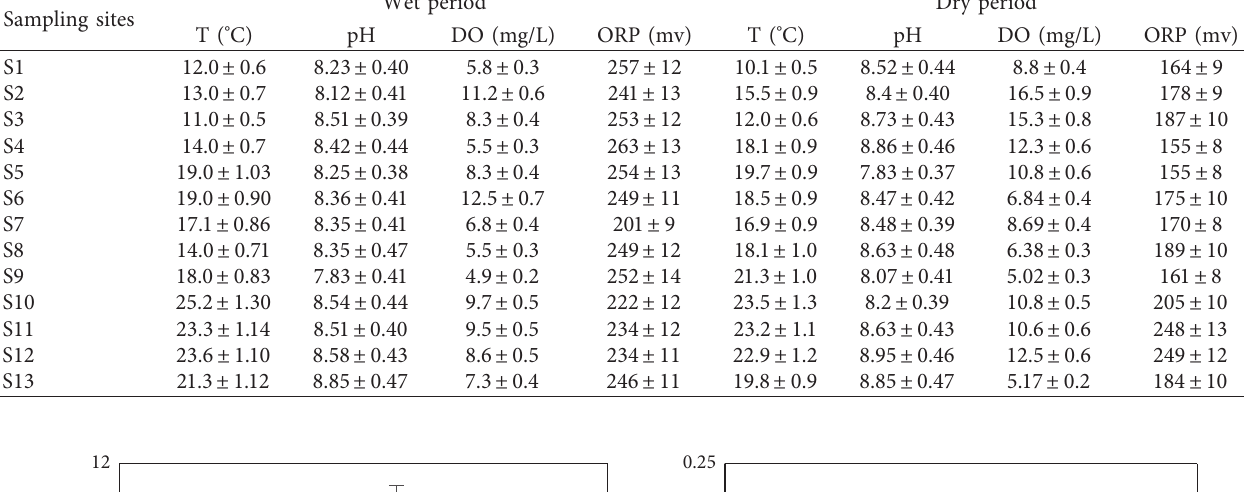
Table 1: Chemical indices in the water samples collected from the upstream of Fenhe River. Sampling sites